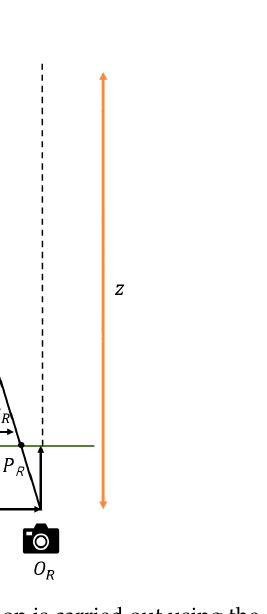
Figure 3. Depth map estimation is carried out using the disparity value and based on the geometric relationship between two image planes.